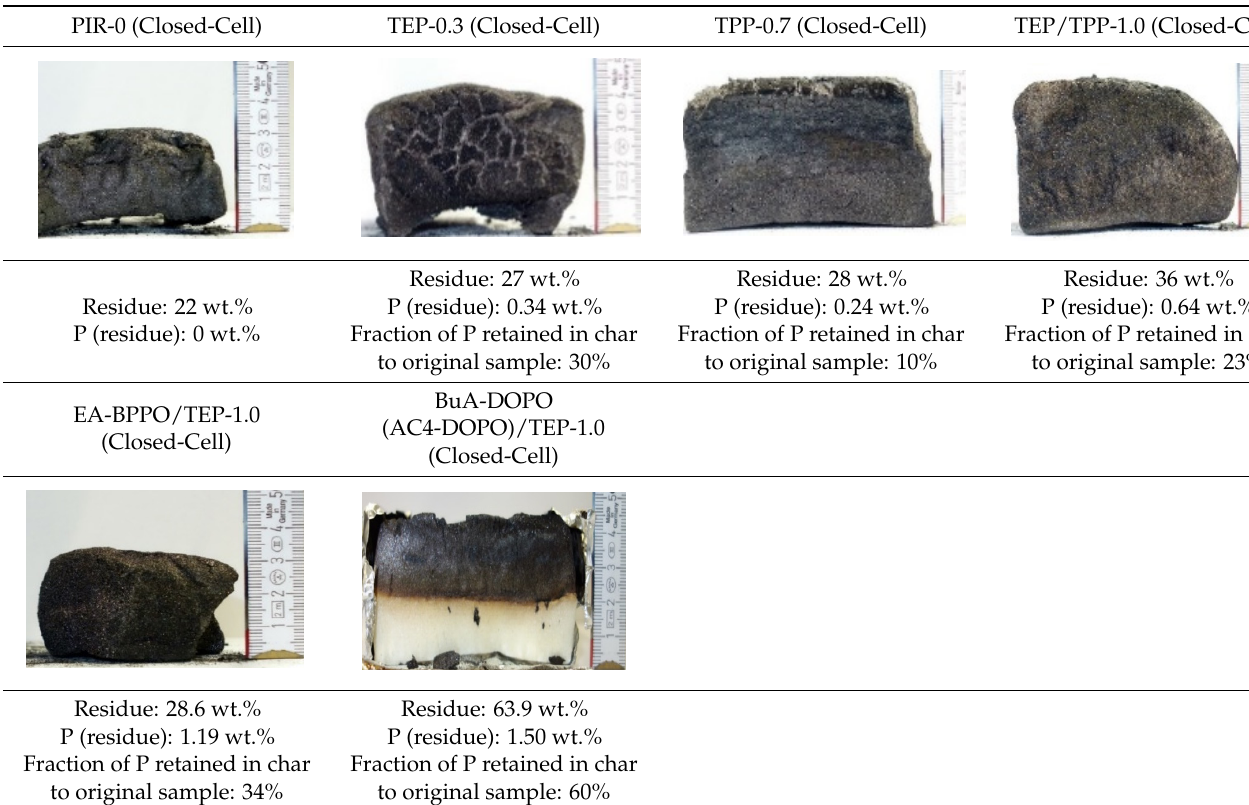
Table 9. Photographic images of the remaining sample residues after cone calorimetric investigations.